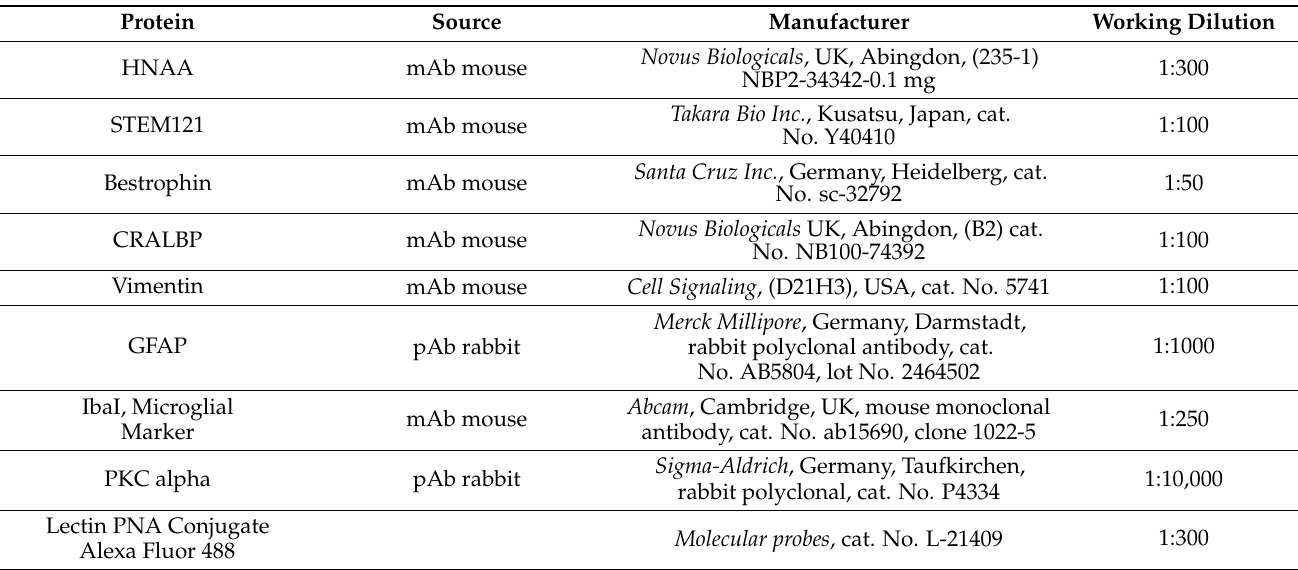
Table 2. Antibodies used for the immunohistochemical